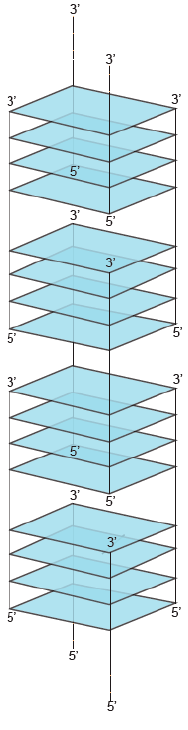
Figure 6. Structure of a G-wire.